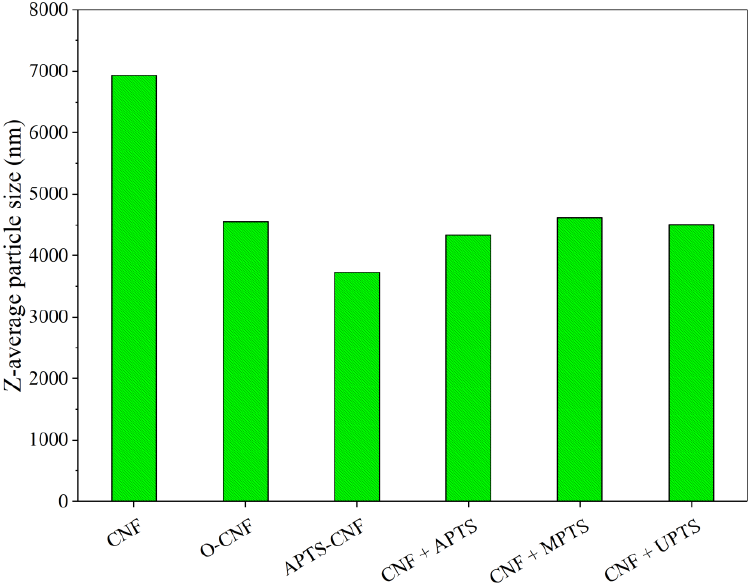
Figure 4. Aggregate sizes for CNF particles modified with di ff erent silane coupling agents.